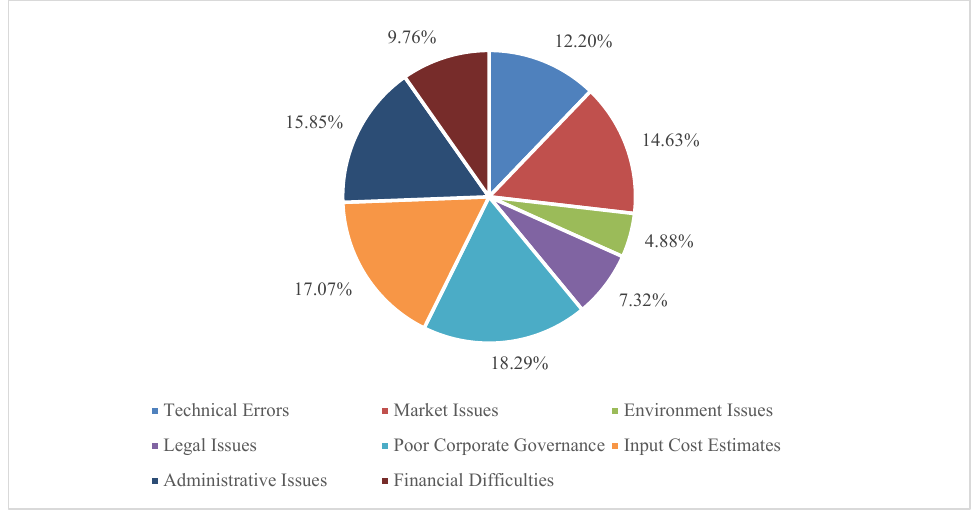
Fig. 2. Factors affecting progress of infrastructure projects